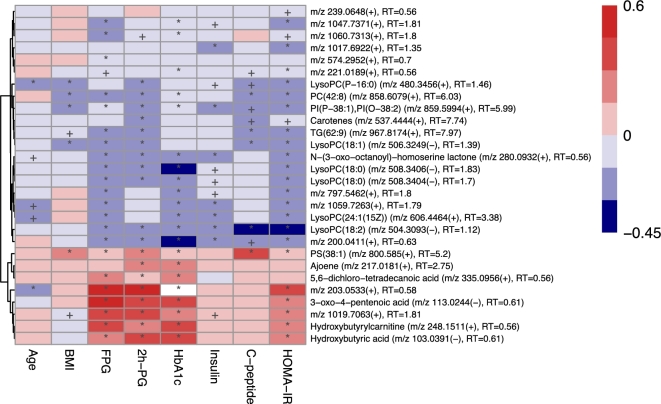
Heatmap of association between clinical parameters and 28 random forest-selected features. A hierarchically clustered heatmap of standardized regression coefficient (beta) of genera linear model analysis showing the correlations between the relative abundances of the 28 significant metabolites and the phenotypes. Red indicates positive correlations, and blue indicates negative correlations. The asterisk denotes a false discovery rate of <0.05 for each regression correlation. The cross denotes a P-value <0.05 and an FDR > 0.05, and the space denotes a P-value ≥ 0.05.